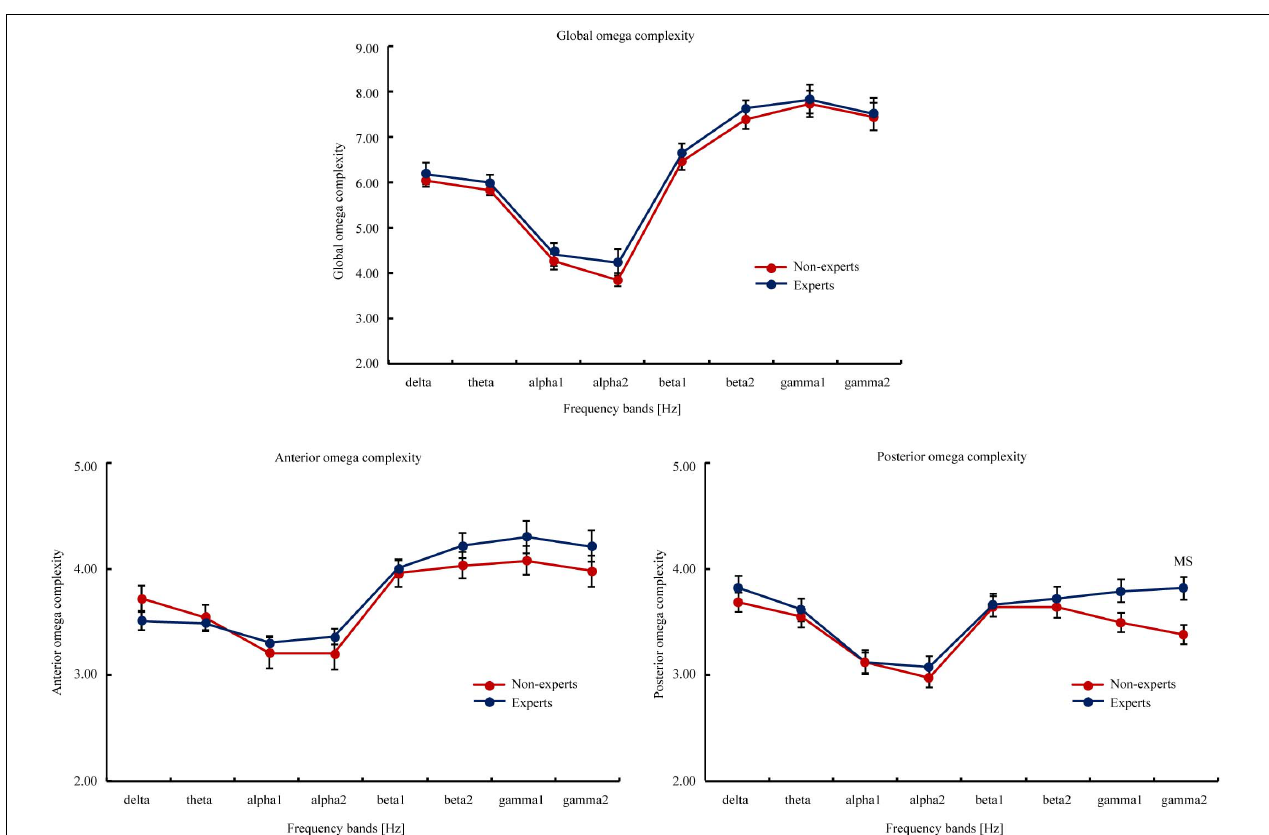
FIGURE 2 | The global, anterior, and posterior omega complexity of the eight EEG frequency bands (i.e., delta, theta, alpha1, alpha2, beta1, beta2, gamma1, and gamma2) in the LOL non-experts and experts. The global omega complexity involved all scalp electrodes; the anterior omega complexity involved FP1, FP2, FT9, FT10, F3, F4, F7, and F8; the posterior omega complexity involved P7, P3, PZ, P4, P8, O1, OZ, and O2. The eight frequency bands involved delta (2–4 Hz), theta (4–8 Hz), alpha1 (8–10.5 Hz), alpha2 (10.5–13 Hz), beta1 (13–20 Hz), beta2 (20–30 Hz), gamma1 (30–40 Hz), and gamma2 (40–60 Hz). Attain values from the interval 1 to m, the lowest value (i.e., 1) means the data is consisted of exactly one principal component or spatial mode, and a maximum synchronization between EEG signals at different scalp locations. The highest value (i.e., m) indicates the total data variance is uniformly distributed across all m principal component, and a maximum spatial complexity is observed. The upper bound on the maximum value is equal to the number of electrodes involved in the calculation. Error bars represent Mean ± SEM. MS indicated marginal significance after FDR